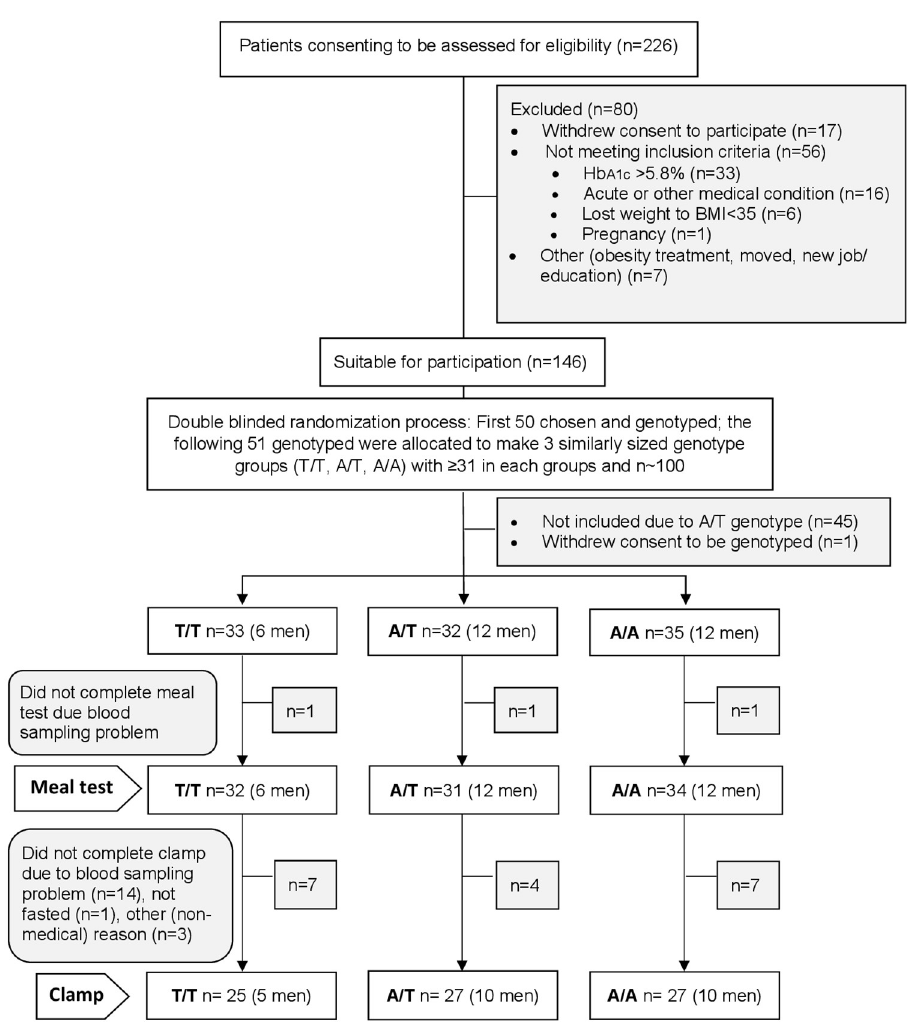
Fig 1. Flow diagram, enrollment and group